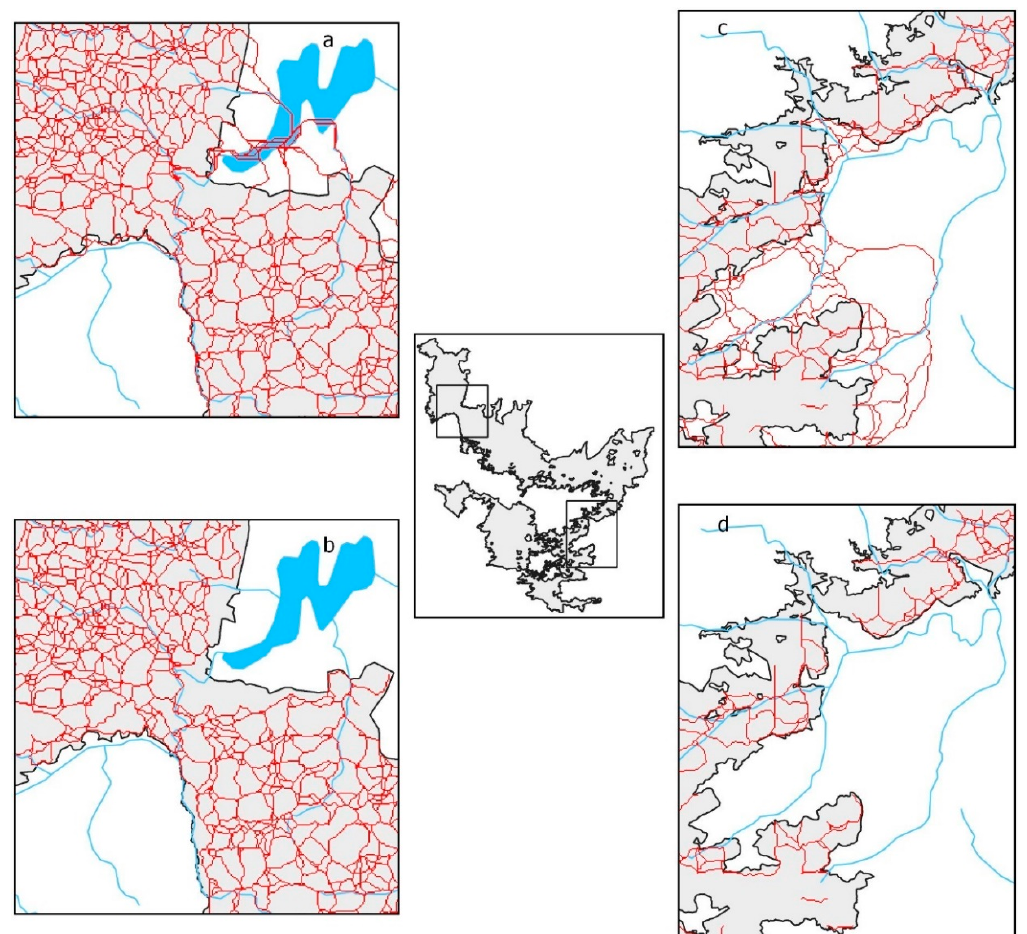
Figure 5. Elephant corridors in the Nilgiri Biosphere Reserve with boundaries open to movement ( a , c ) and with boundaries closed to movement ( b , d ). Water bodies (in blue), including an artificial lake, were not considered to oppose resistance to movement.